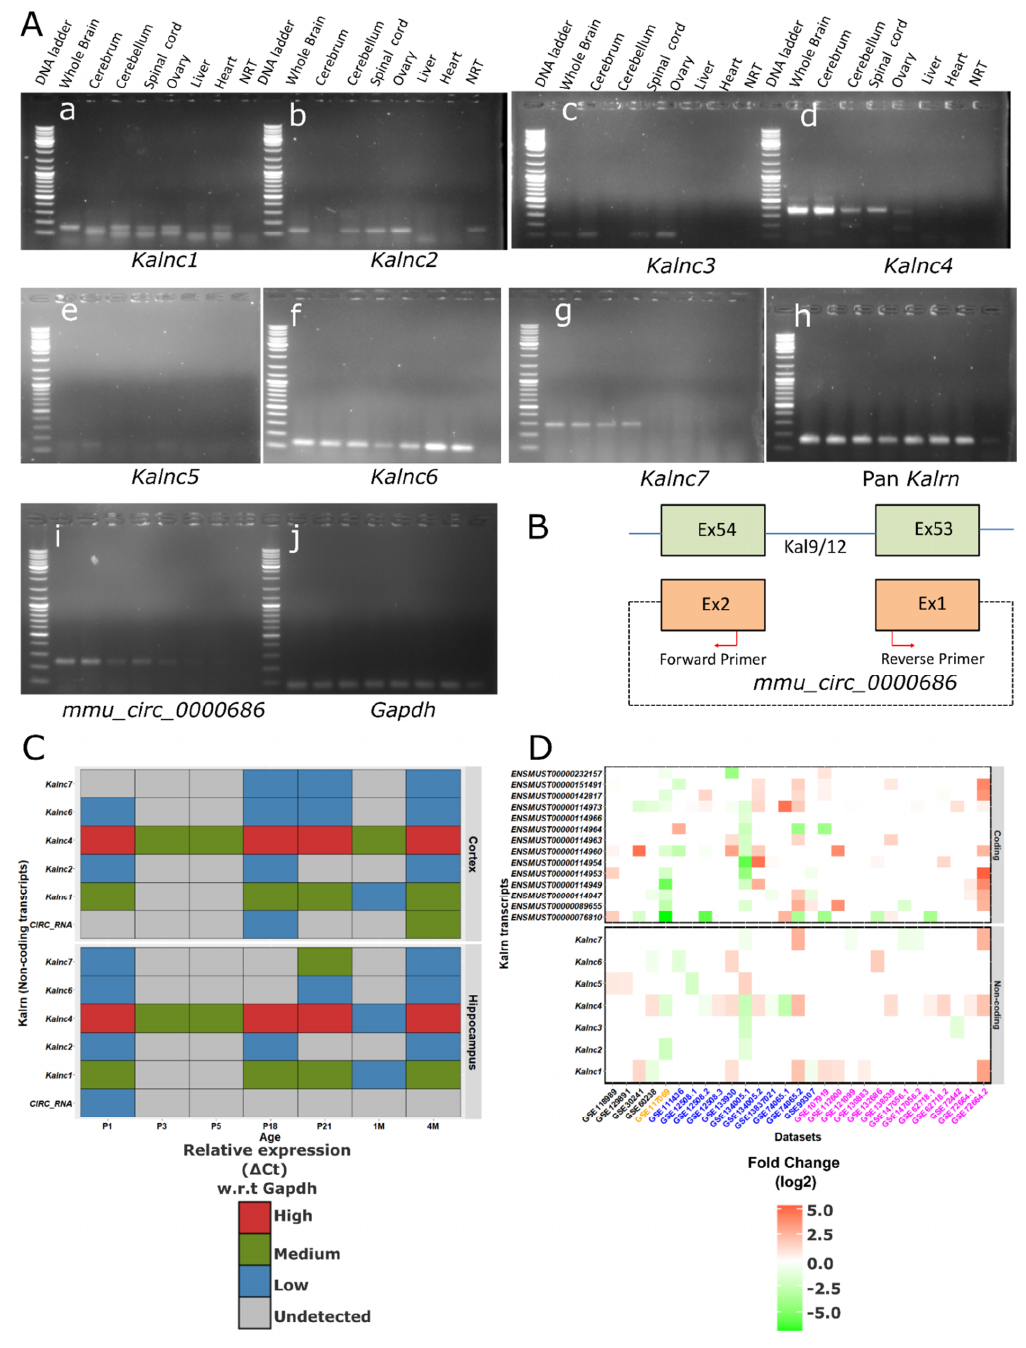
Figure 2. Kalrn locus lncRNAs are brain-enriched. ( A ) Representative images of endpoint RT-PCR showing expression of Kalrn loclncRNAs: Kalnc1 (155 bps), Kalnc2 (131 bps), Kalnc3 (112 bps), Kalnc4 (376 bps), Kalnc5 (142 bps), Kalnc6 (138 bps), Kalnc7 (295 bps); pan Kalrn (157 bps), mmu_circ_0000686 (217 bps), and Gapdh (75 bps) in ( a – j ) respectively in the whole brain, cerebrum, cerebellum, spinal cord, ovary, liver, and heart. ( B ) Schematic illustration of the circular RNA mmu_circ_0000686 at mouse Kalrn locus. ( C ) Relative expression of Kalrn locus lncRNAs was measured in mouse cortex and hippocampus at different time points (P1, P3, P5, P18, P21, 1 M, and 4 M) by qRT-PCR. (Data are shown as mean (SD), N = 3 biological replicates; n = 3 technical replicates). ( D ) A heatmap of mouse datasets associated with schizophrenia (black label), addiction (orange label), epilepsy (blue label), and autism (magenta label). Each row represents protein-coding (top panel) or non-coding (bottom panel) transcripts arising from the Kalrn locus. Labels include ID of GEO